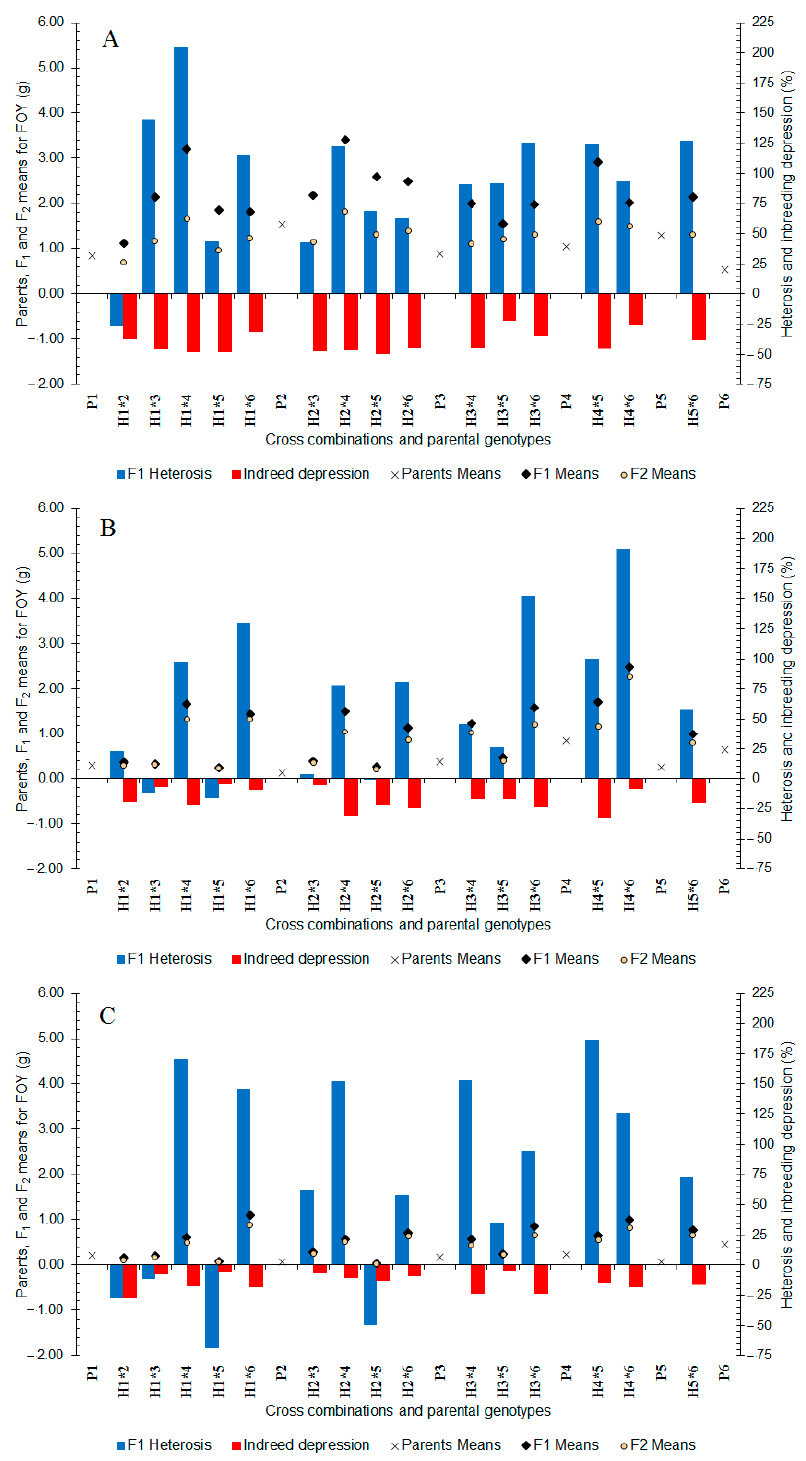
Figure 5. Mean, heterosis, and inbreeding depression for fatty oil yield in F 1 and F 2 generations of coriander crosses. ( A ) Well-Watered, ( B ) Moderate Water Stress, and ( C ) Severe Water Stress. P 1 –P 6 : six parental coriander genotypes; H 1×2 –H 5×6 : 15 half-diallel hybrids. However, estimation of heterosis for seed yield, fatty oil, and essential oils content will help in identifying crosses that can lead to the development of advanced, promising lines in segregating generations in coriander. Furthermore, estimation of heterosis cou- pled with inbreeding depression shows whether an amount of the vigor observed in seg-